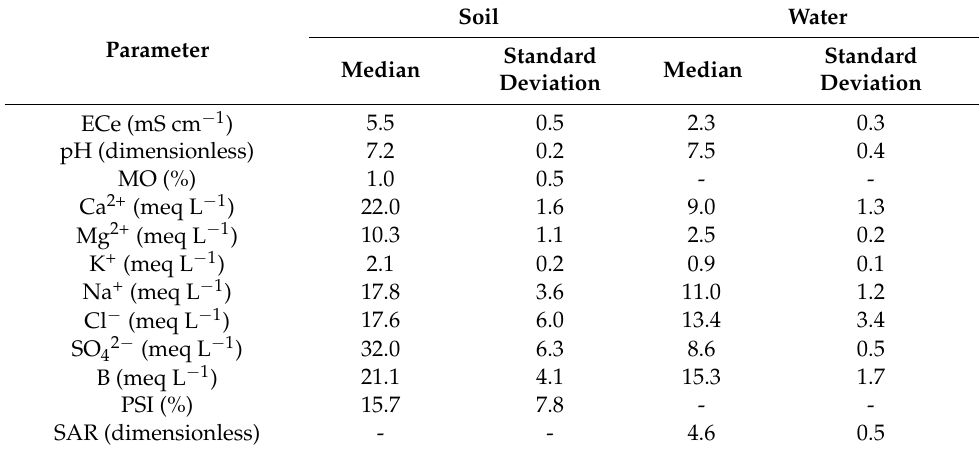
Table 3. Chemical characterization of soil and water at the study site (Rosario sector, Lluta valley). The values correspond to the median and standard deviation of electrical conductivity of the extract (ECe), pH, organic material (MO), charge concentration of calcium (Ca 2+ ), magnesium (Mg 2+ ), potassium (K + ), sodium (Na + ), chloride (Cl − ), sulfate (SO 42 − ), boron (B), percentage of exchangeable sodium (PSI), and sodium adsorption ratio (SAR) in soils of the study site. Soil Water Parameter Standard Standard Median Median Deviation Deviation ECe (mS cm − 1 ) 5.5 0.5 2.3 0.3 pH (dimensionless) 7.2 0.2 7.5 0.4 MO (%) 1.0 0.5 - - Ca 2+ (meq L − 1 ) 22.0 1.6 9.0 1.3 Mg 2+ (meq L − 1 ) 10.3 1.1 2.5 0.2 K + (meq L − 1 ) 2.1 0.2 0.9 0.1 Na + (meq L − 1 ) 17.8 3.6 11.0 1.2 Cl − (meq L − 1 ) 17.6 6.0 13.4 3.4 SO 42 − (meq L − 1 ) 32.0 6.3 8.6 0.5 B (meq L − 1 ) 21.1 4.1 15.3 1.7 PSI (%) 15.7 7.8 - - SAR (dimensionless) - - 4.6